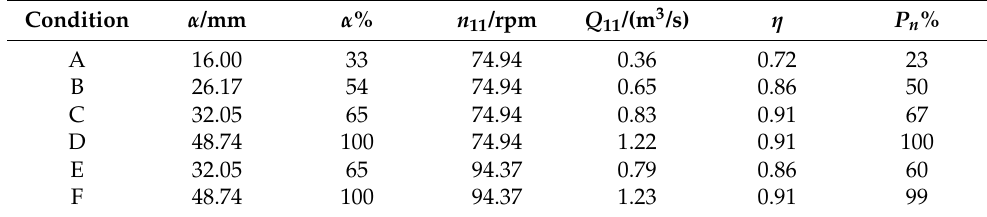
Figure 3. Combined characteristic curve of Francis turbine HLA551-LJ-35. Table 1. Details of six working